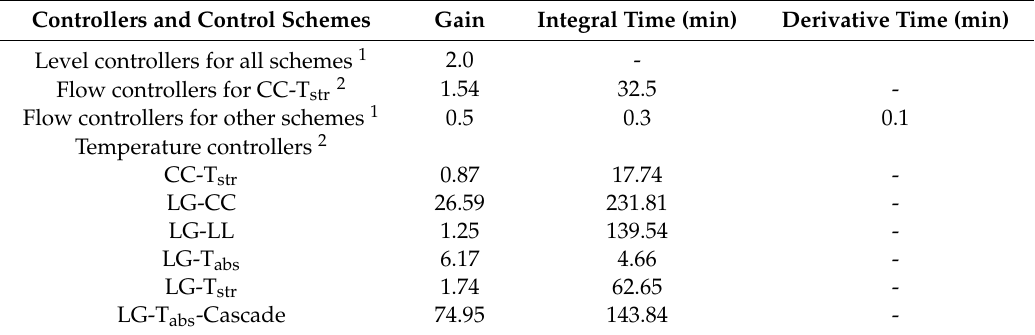
Table 2. Tuning parameters of the Proportional–Integral–Derivative (PID) controllers for the same inventory controllers used for all control schemes and for the quality controllers of each control scheme. Controllers and Control